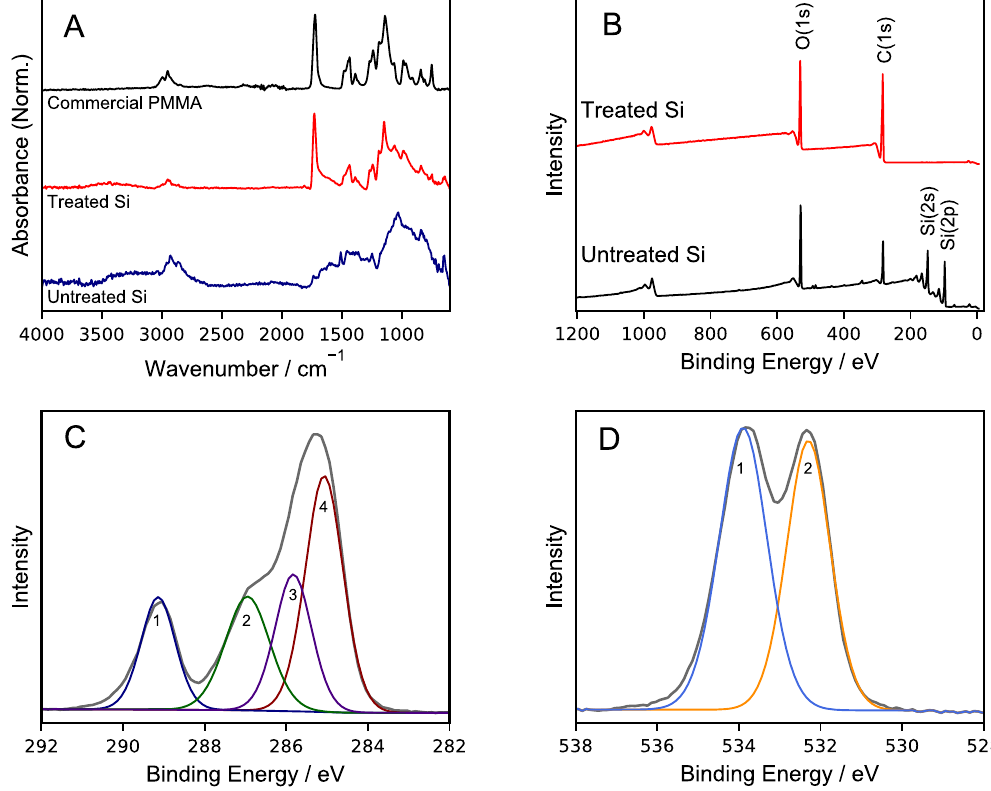
Figure 2. ( A ) FTIR-ATR spectra for (un)treated silicon to verify surface treatment. ( B ) XPS survey scans of (un)treated silicon. Also shown are high resolution XPS spectra (grey) and fits for ( C ) carbon and ( D )